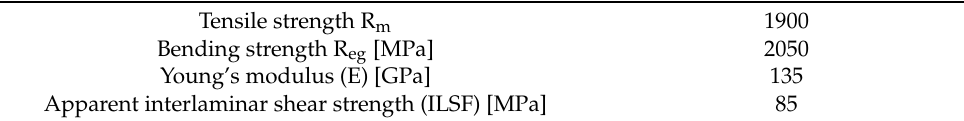
Table 1. Selected properties of the CFRP composite used in the test [40].